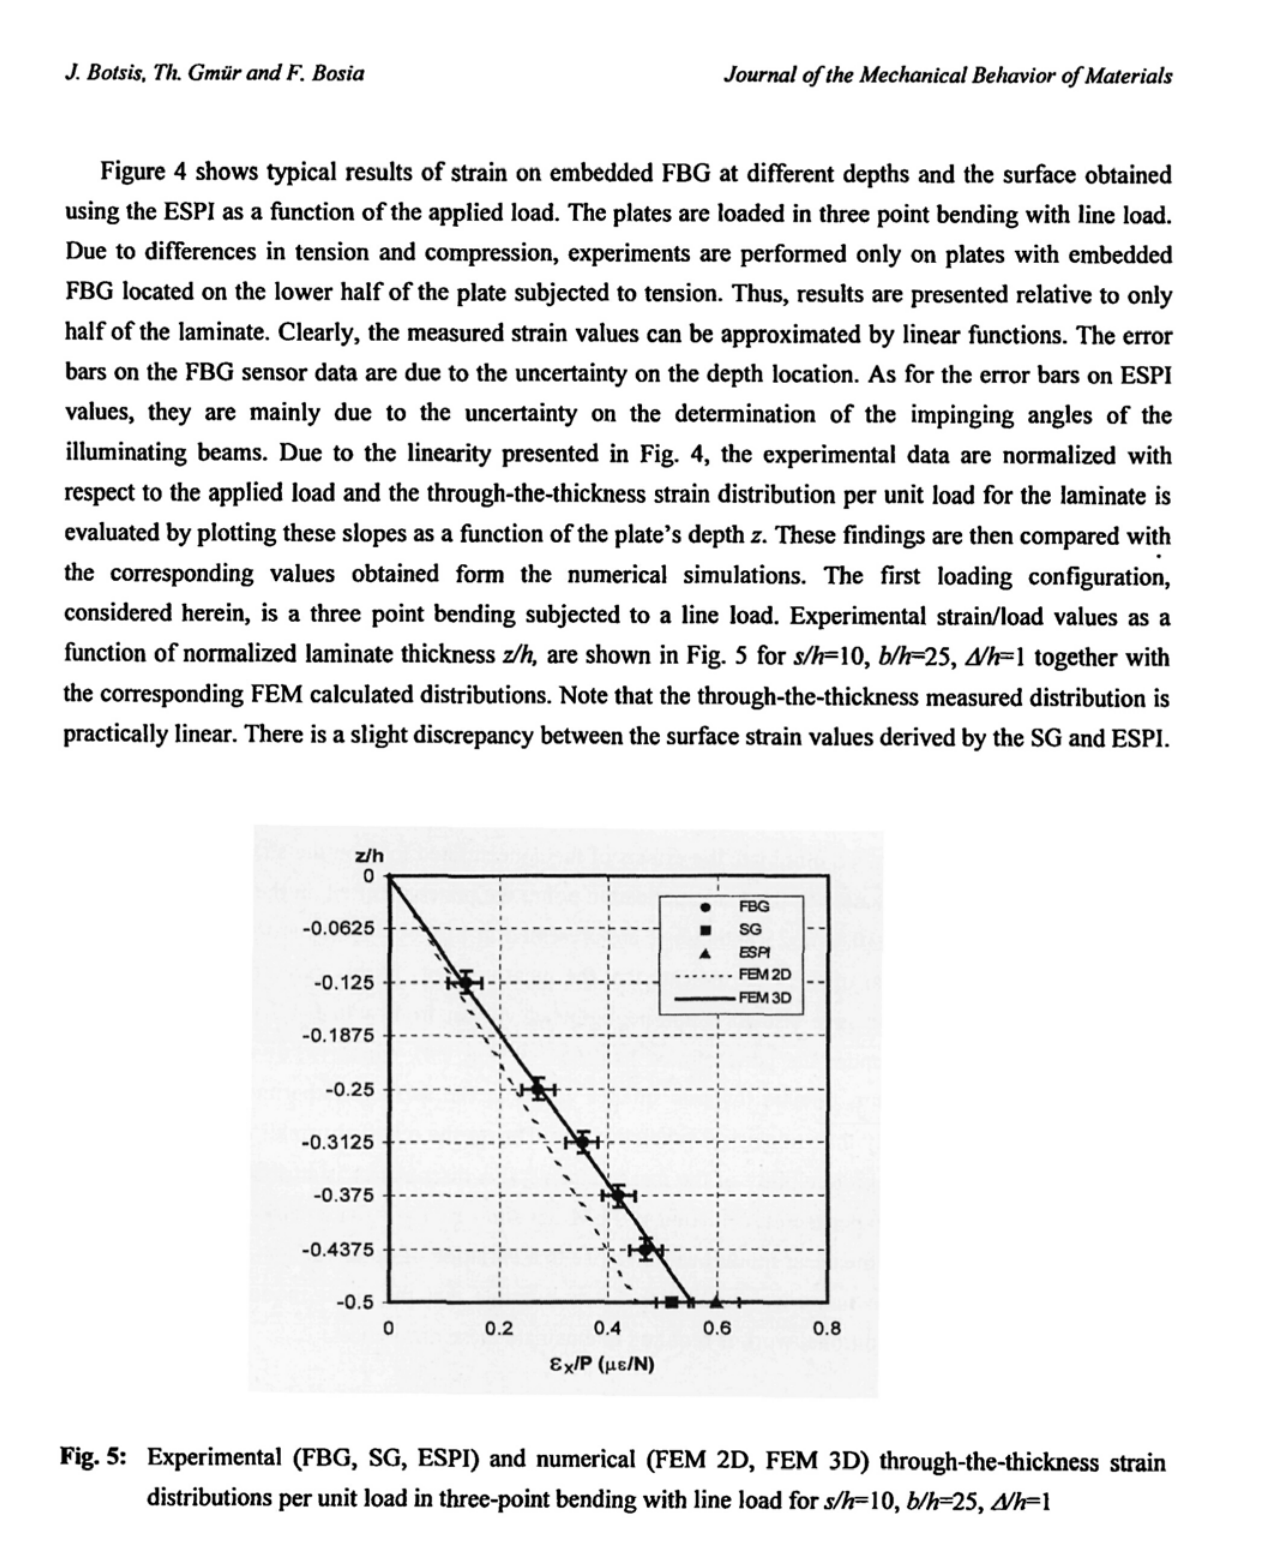
Fig. 5: Experimental (FBG, SG, ESPI) and numerical (FEM 2D, FEM 3D) through-the-thickness strain distributions per unit load in three-point bending with line load for s/h=\0, b/h=25,